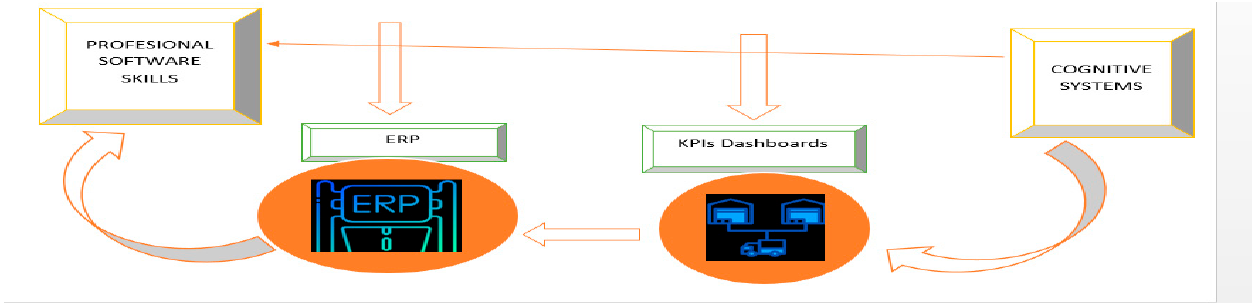
Figure 3. Artificial intelligence for industrial use.